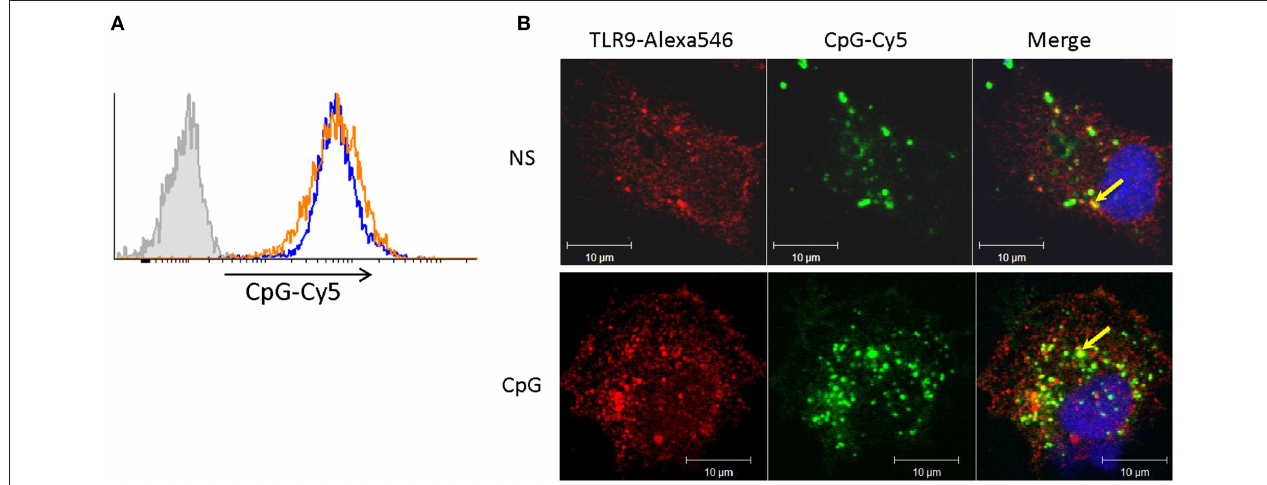
FIGURE 4 | Cells stimulated with CpGs for 7 days retain capacity to take up CpG ODNs and to translocate them into TLR9-positive endocytic compartments. (A) MPs were either left non-stimulated (blue contour) or were treated with 2 µ M CpGs for 7 days (orange contour) prior to incubation with fluorescent (CpG-Cy5) ODNs for 1h and flow cytometry analysis. The filled gray contour represents cells incubated without fluorescent CpGs. (B) Non-stimulated cells (NS) and cells pretreated with CpGs for 7 days were incubated with CpG-Cy5 for 1h prior to fixation, permeabilization, and staining of intracellular TLR9. The endocytosed CpGs were visualized in the far-red channel and are shown in green pseudocolor. The nuclei were stained with SYTOX Green (blue pseudocolor). The colocalization between TLR9 and CpG-positive vesicles (yellow color) is indicated with arrows in the merged images.